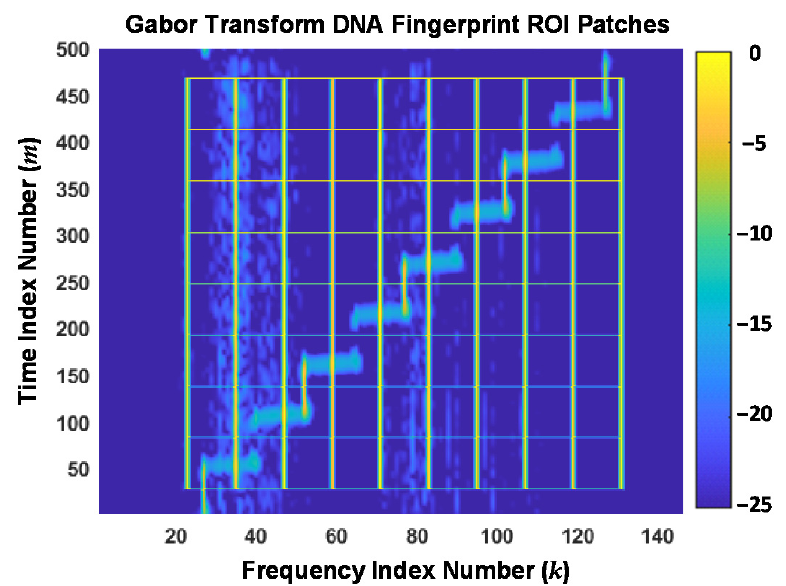
Figure 6. Overlay of the Gabor transform magnitude response from Figure 5 with the selected 2D fingerprinting ROI patch boundaries overlaid.